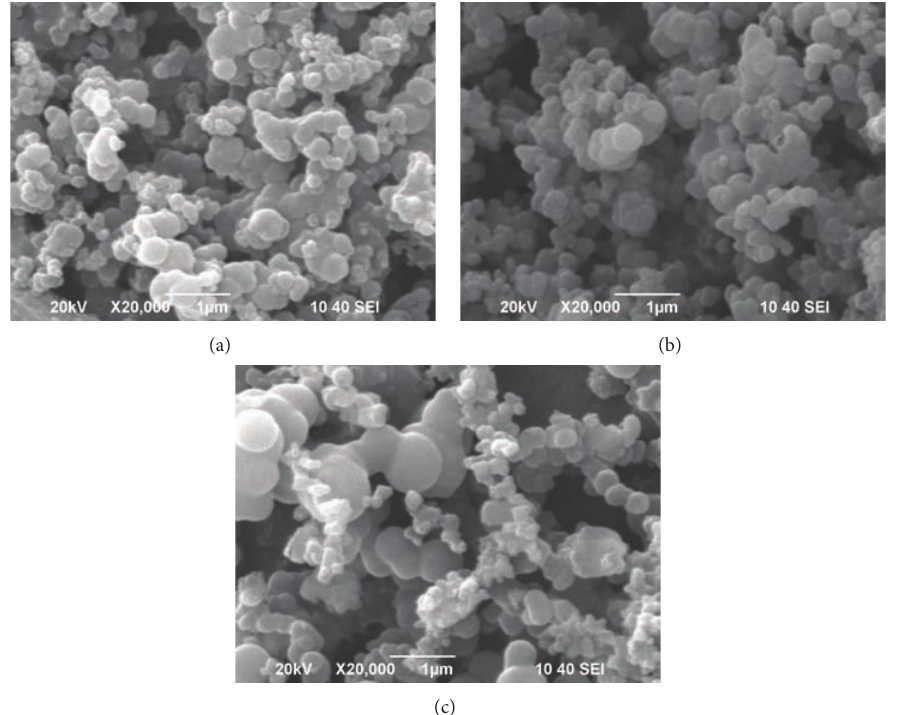
Figure 2: SEM images of the product (a) 1:60, (b) 1:40, and (c) 1: 20.